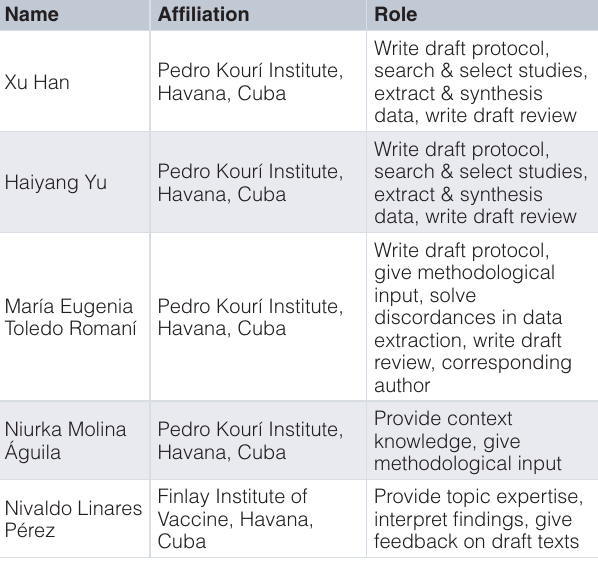
Table 4. Review team, affiliations and